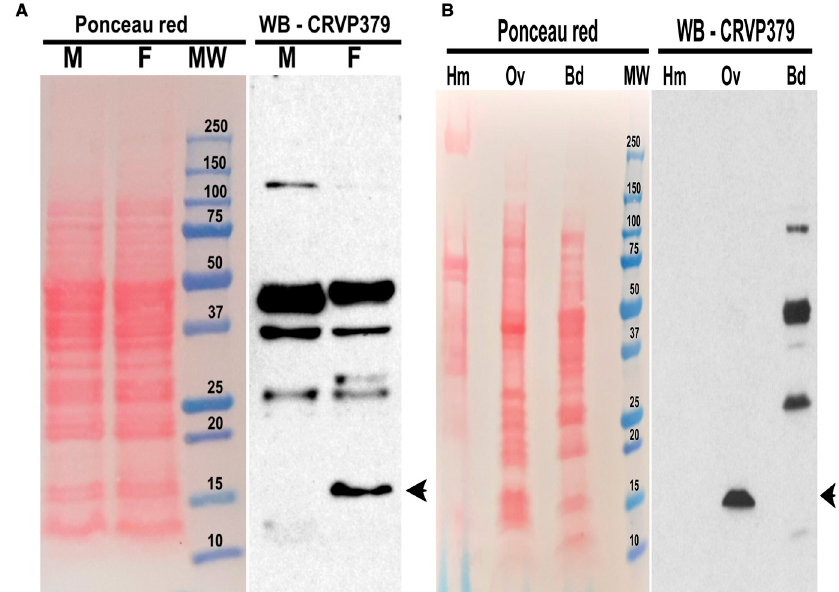
Figure 2. Western blot of CRVP379: the left panel shows protein staining with Ponceau red; the right panel shows western blotting with the CRVP379 antibody. In ( A ) M: male whole body; F: female whole body, MW: molecular weight marker. ( B ) Hm: female hemolymph; Ov: female ovaries; Bd: remaining female body without ovaries or hemolymph. Arrowhead—CRVP379.